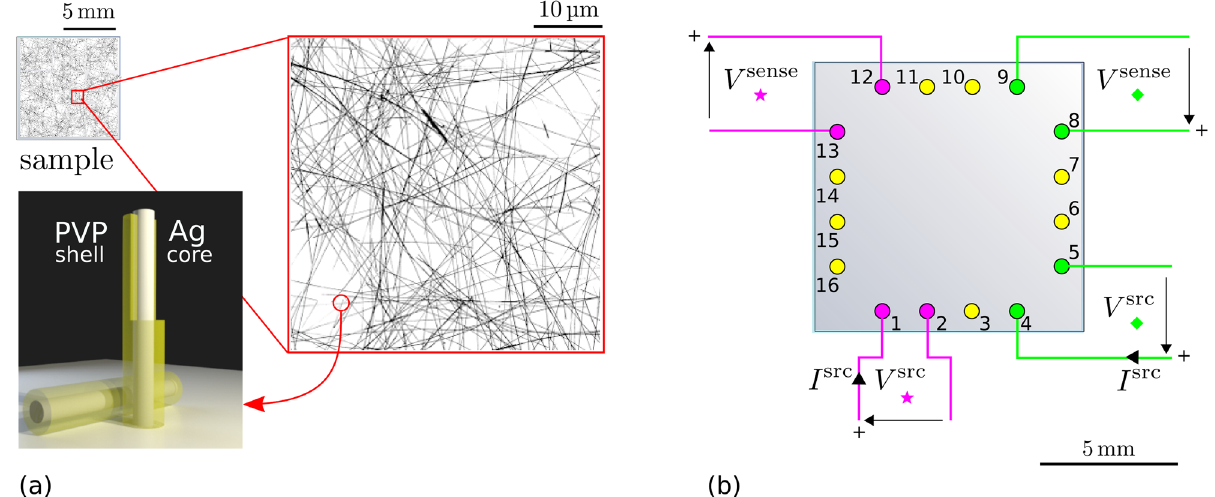
Figure 1. Nanowire network sample on quartz support: illustration of the 1 × 1cm 2 sample, SEM micro- graph detail of one of the studied samples and a pictorial representation of PVP-Ag nanowires ( a ). Schematic representation of the placement of the contact array over the sample. Two examples of ERT four-terminal resistance measurements configurations are shown with the corresponding excitation and sensing quantities ( b